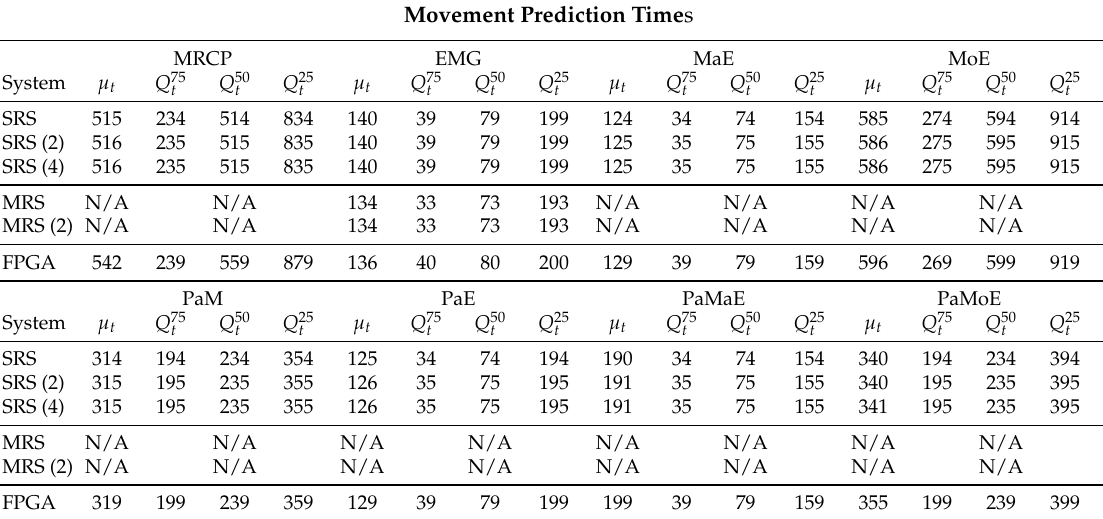
Figure 14. Predictions relative to the movement onset of the CPU and FPGA-based systems for the PaMaE and PaMoE combinations. For a more detailed figure description, see Figure 13. Table 3. Prediction times in ms before movement onset (N/A: not